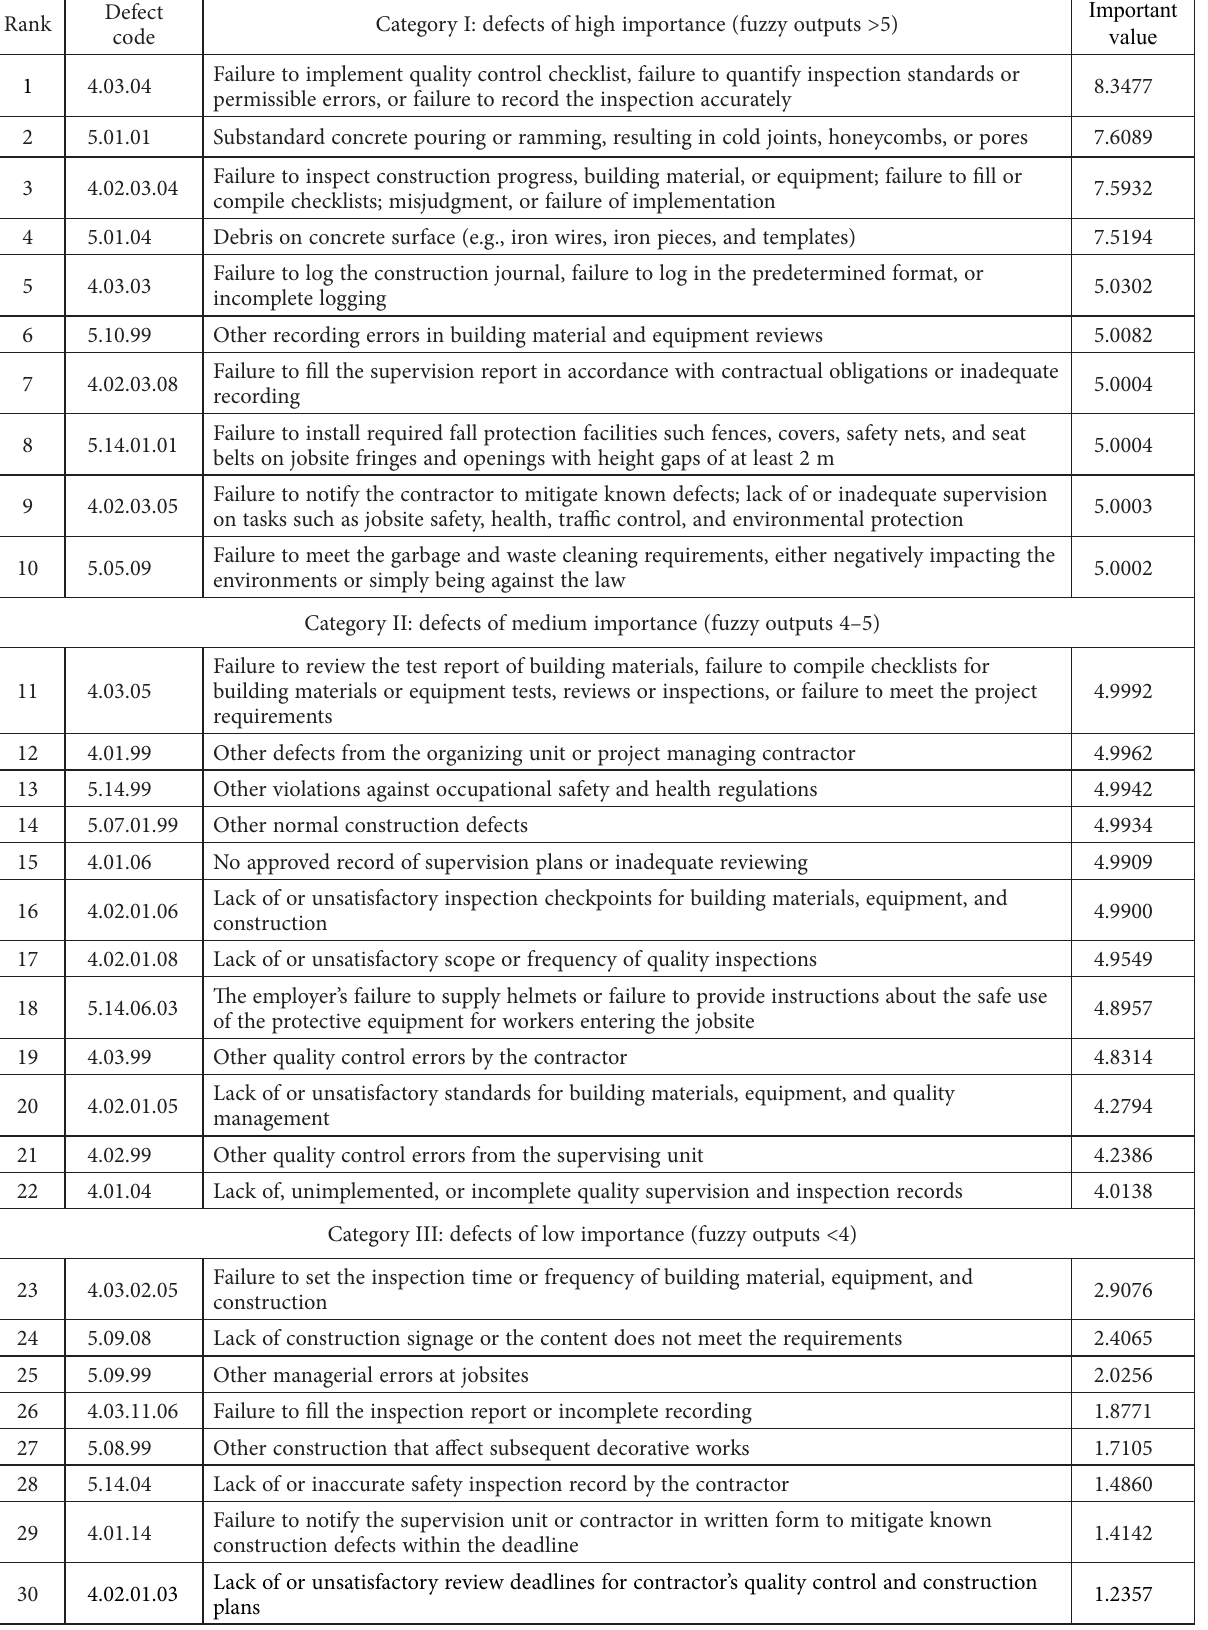
Table 7. Important value of critical